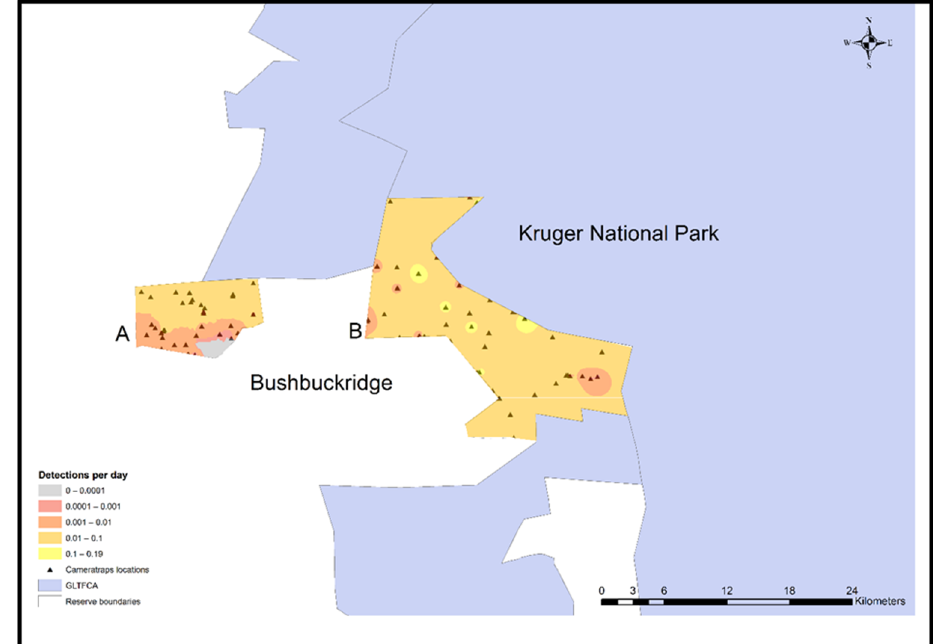
Figure 4. Other carnivore (spotted hyena, civet, and genet) daily detection model for Andover ( A ) and Manyeleti ( B ) nature reserves adjacent to Bushbuckridge human settlement and Kruger National Park, Mpumalanga Province, South Africa, 2015–2017.